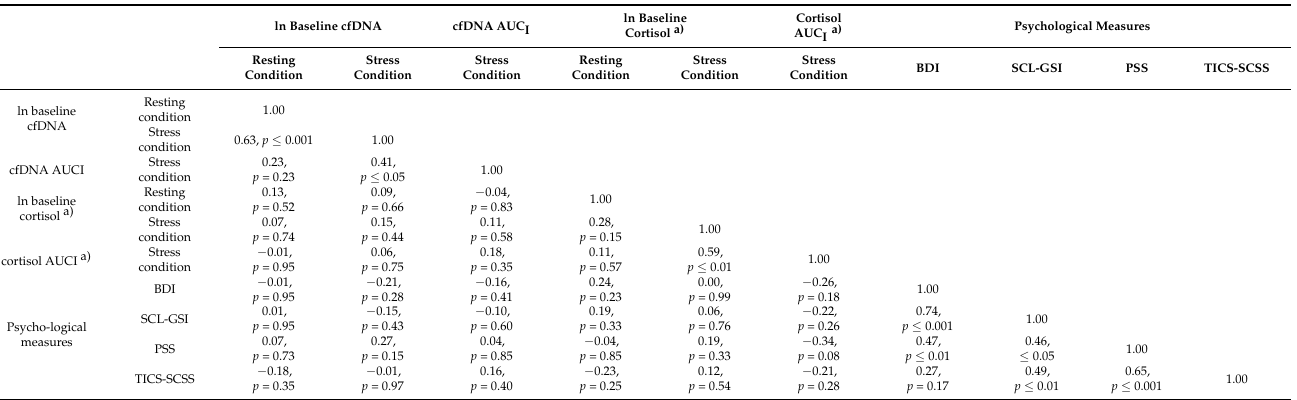
Table 3. Pearson’s correlations (r) between psychological, cfDNA, and cortisol measures.